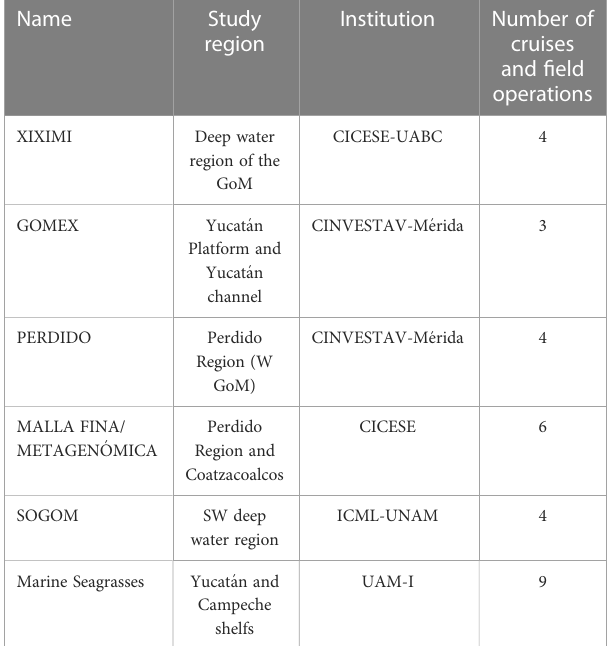
TABLE 1 Oceanographic cruises in the Gulf of Me ́ xico by CIGoM (2015-